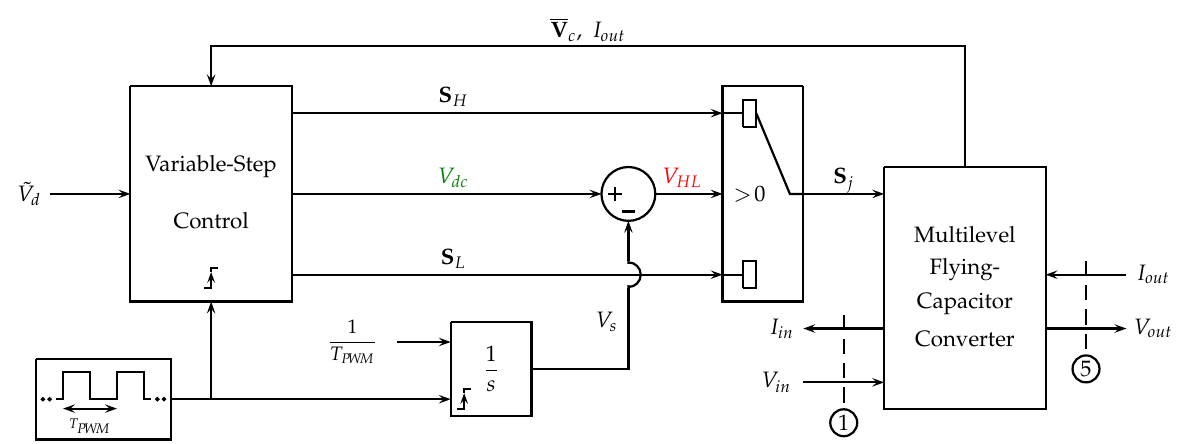
Figure 24. PWM physical scheme and Variable-Step Control of the Multilevel Flying-Capacitor Converter. The basic elements of the new PWM scheme are the